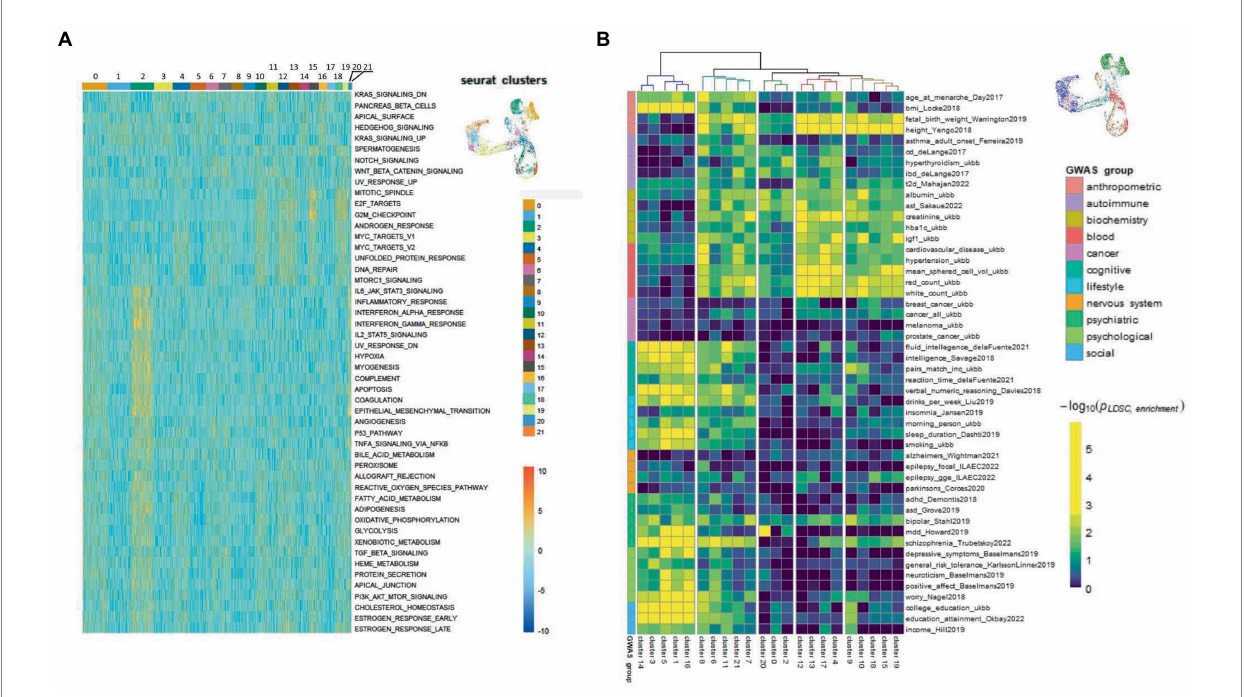
FIGURE 9 Functional and genetic signatures for identified cell clusters in the scRNA-seq data from N-KYOU p5 and p25. (A) Functional interpretation of a list of genes, specific for each cluster. Heatmap of top clustered Hallmark ontologies is shown. Columns represent scRNA-seq cell clusters, colored as in bar on the right with UMAP picture as a reference. (B) Heatmap of representative LDSC results for each cluster. Heatmap color is LDSC enrichment [ − log 10 ( p -values), p -values are BH adjusted]. Rows are traits grouped in 11 categories. Columns are scRNA-seq cell clusters. Only 50 of the most enriched traits in every category are shown due to lack of drawing space; the whole data are present in Supplementary Table S9. Colors on the UMAP reference picture are the same as those of the cluster branches on top of the heatmap and correspond to five major groups, defined in the LDSC